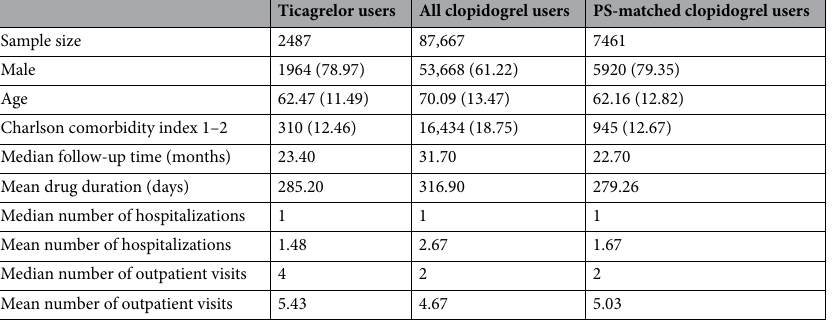
Table 1. Baseline characteristics of the patients with conditions other than recent ACS. ACS acute coronary syndrome, PS propensity